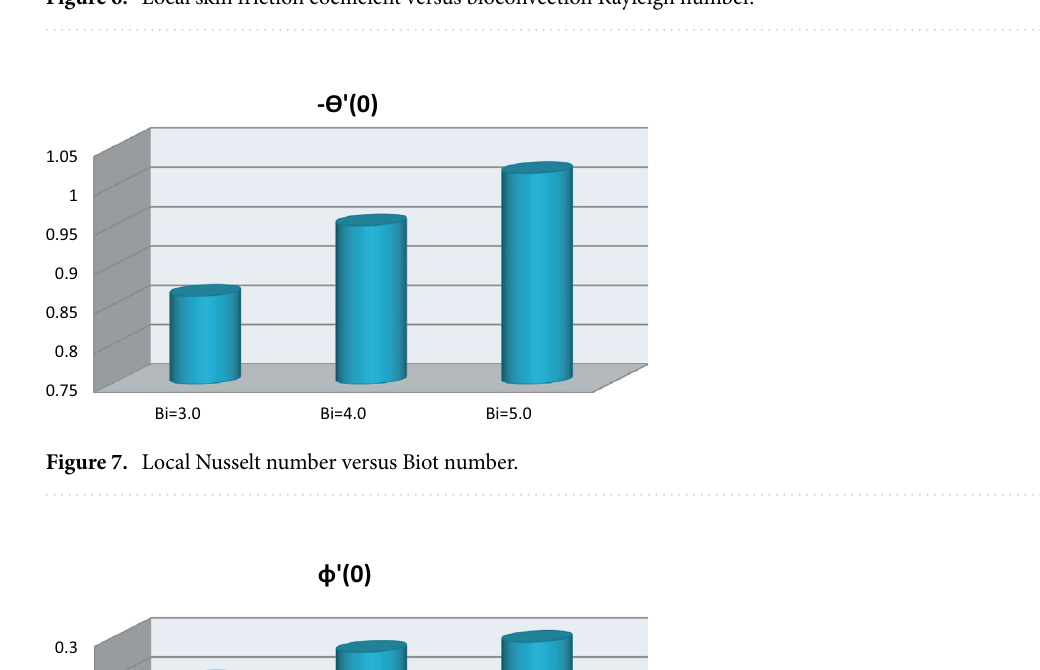
Figure 6. Local skin friction coefficient versus bioconvection Rayleigh number.